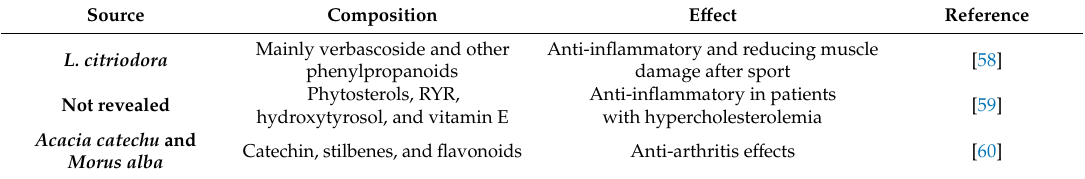
Table 2. List of available nutraceuticals to manage inflammatory